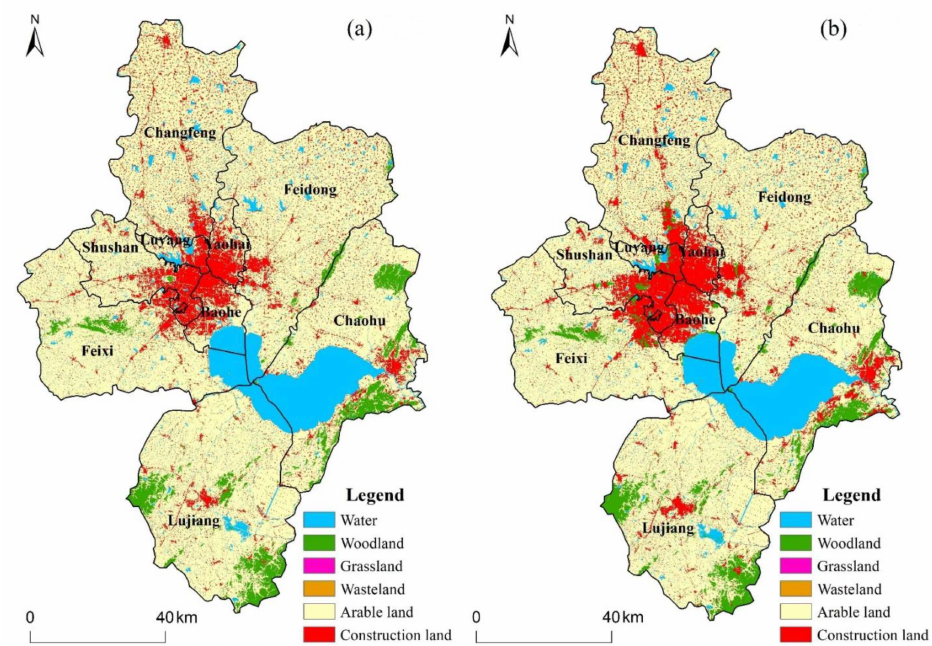
Figure 2. LULC classification maps of Hefei for ( a ) 2020, ( b ) 2030.